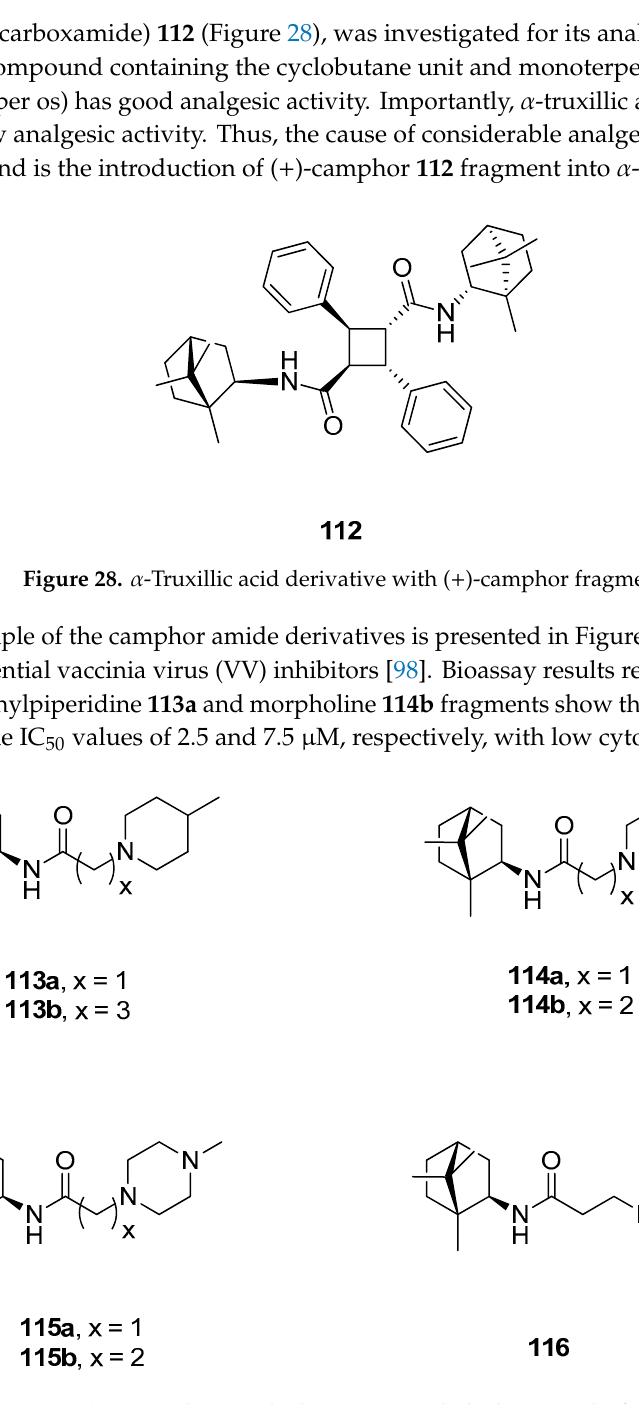
111 Figure 27. (+)-Camphor N -acylhydrazones with various aliphatic, aromatic, and heterocyclic substituents.